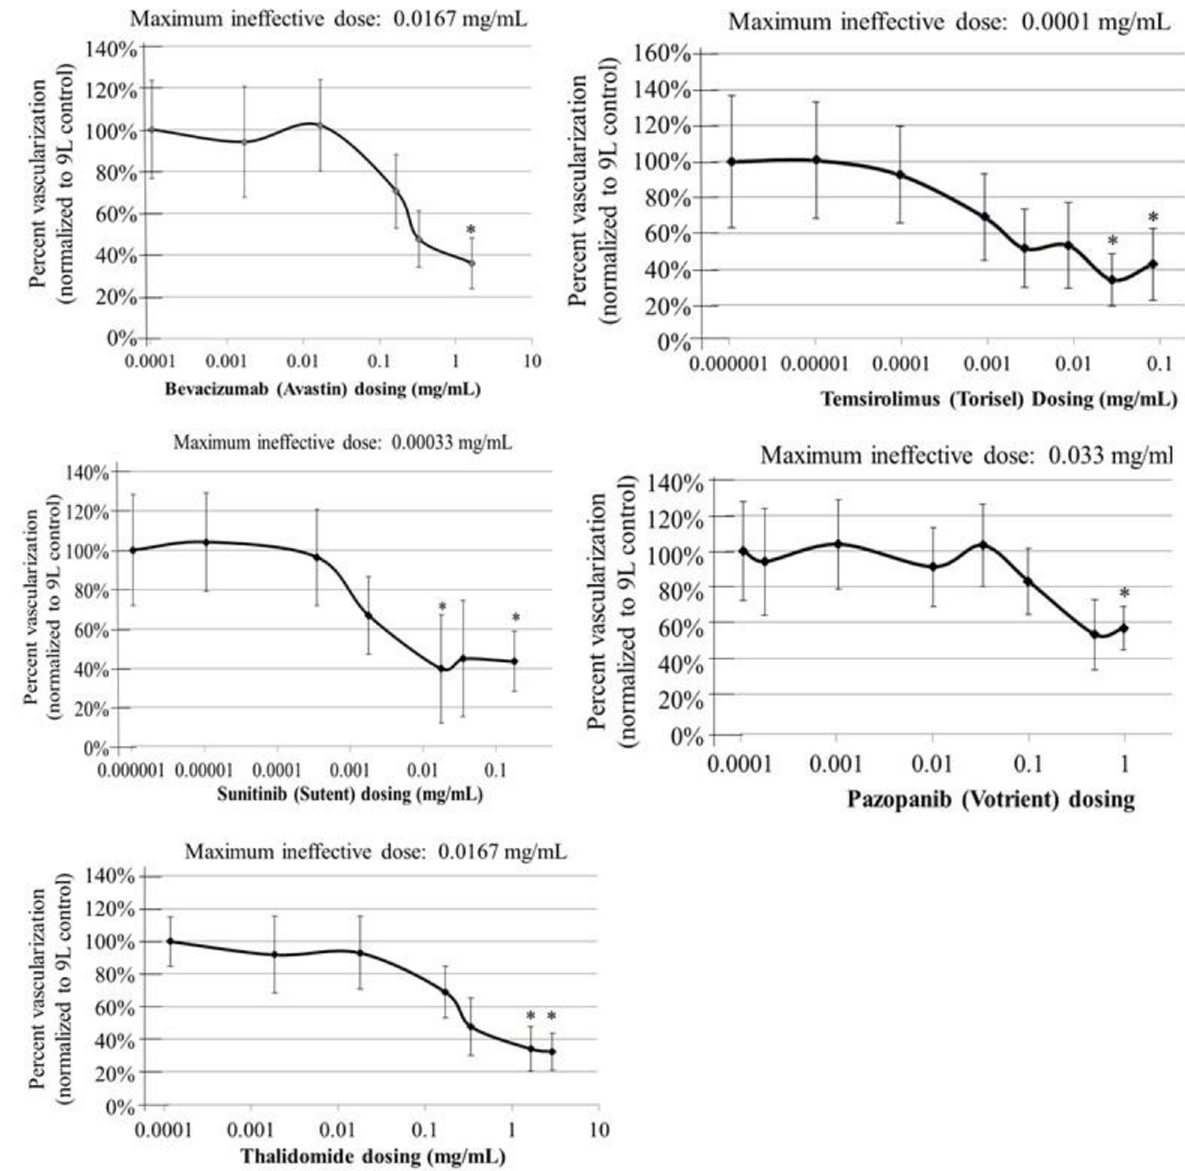
Fig 3. Monotherapy dosing of angiostatics in the CAM model. Monotherapies were tested at multiple doses in order to ensure activity based on the inhibition of tumor-induced neovascularization in our model system. Once this functional activity was confirmed, the maximum dose of no effect was identified for each of the various angiostatic monotherapies that demonstrated activity in the CAM model. The indicated maximum ineffective doses were subsequently used to screen for synergistic combinations ensuring that any observed tumor NV inhibiting activity was due to exponential benefits in combination. Asterisks indicate significant reduction in tumor vascularization compared to the untreated controls.